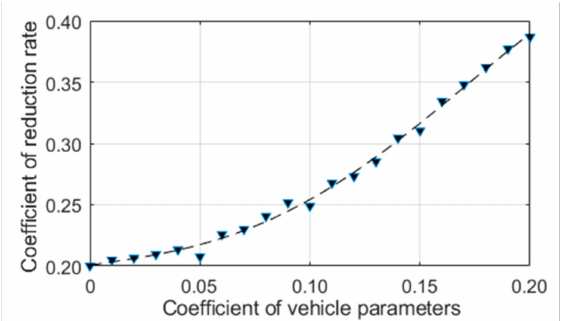
Figure 16. Relationship between variation coefficients of the vehicle parameters and wheel load reduction rate.